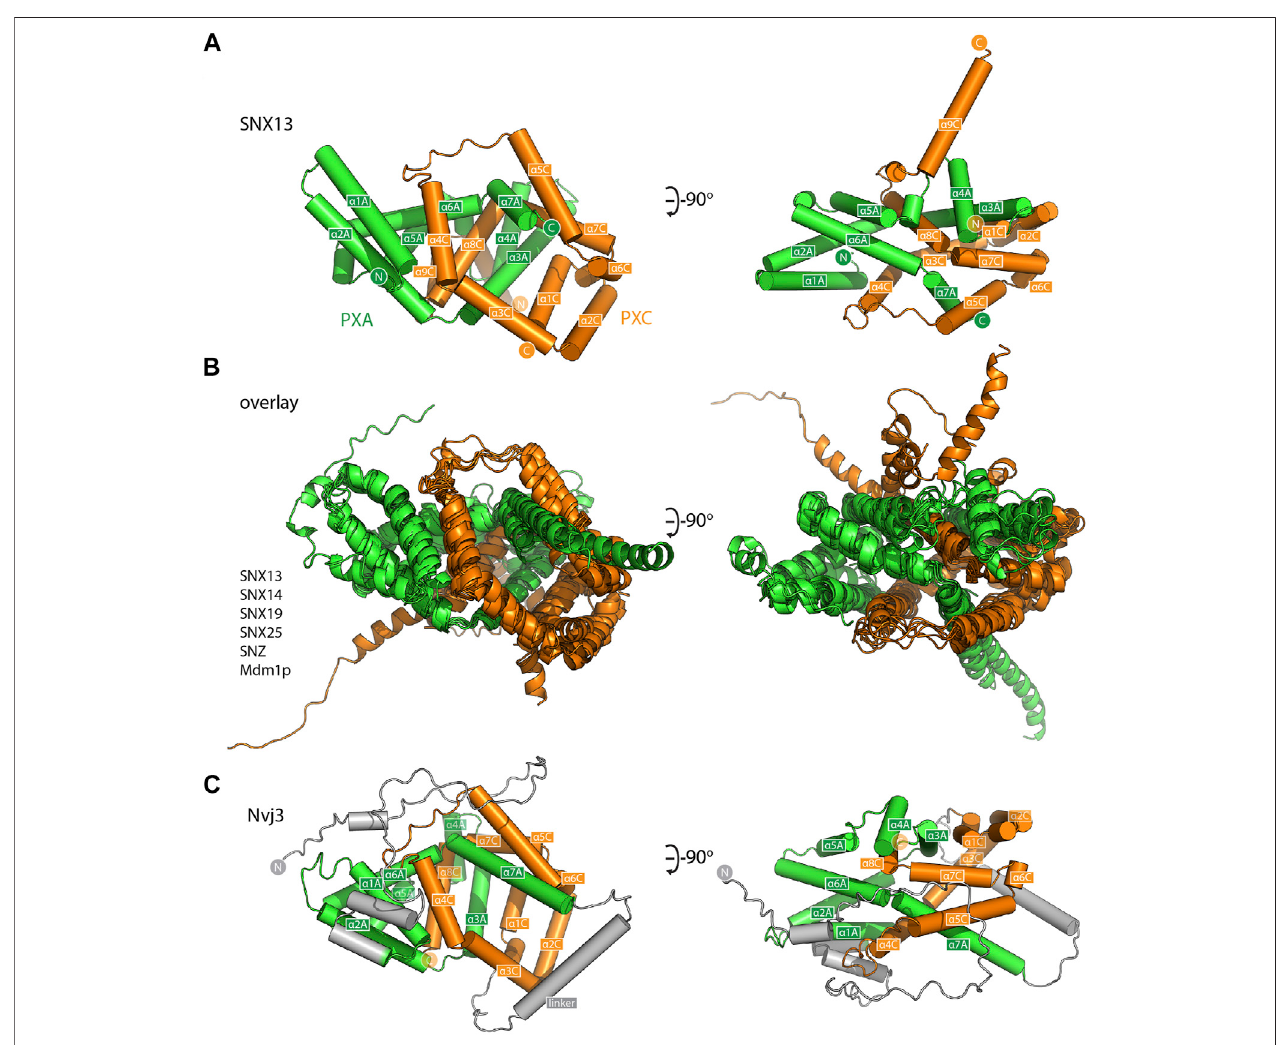
FIGURE3 | The PXA and PXC domains combine to form an intertwined α -helical structure. (A) Structure of thePXA and PXC domains ofhuman SNX13 predicted by AlphaFold2 in green and orange respectively, shown with cylinders for α -helices. The two domains are predicted to be tightly interwoven. (B) An overlay of the core PXA-PXC domains of human, yeast and fl y SNX-RGS proteins shows that all predicted structures have the same topology. (C) Predicted structure of S. cerevisiae Nvj3 with the regions expected to be similar to PXA and PXC domains coloured green and orange and the linker shown in grey.